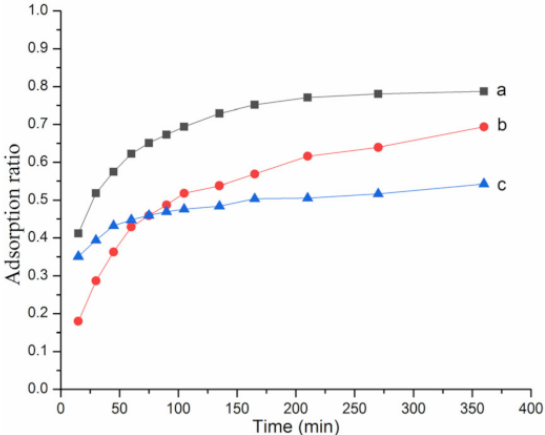
Figure 3. Adsorption Ratio of MO adsorbed by PANI composites with different amounts of ZnO, ( a ) 0%; ( b ) 8% and ( c )